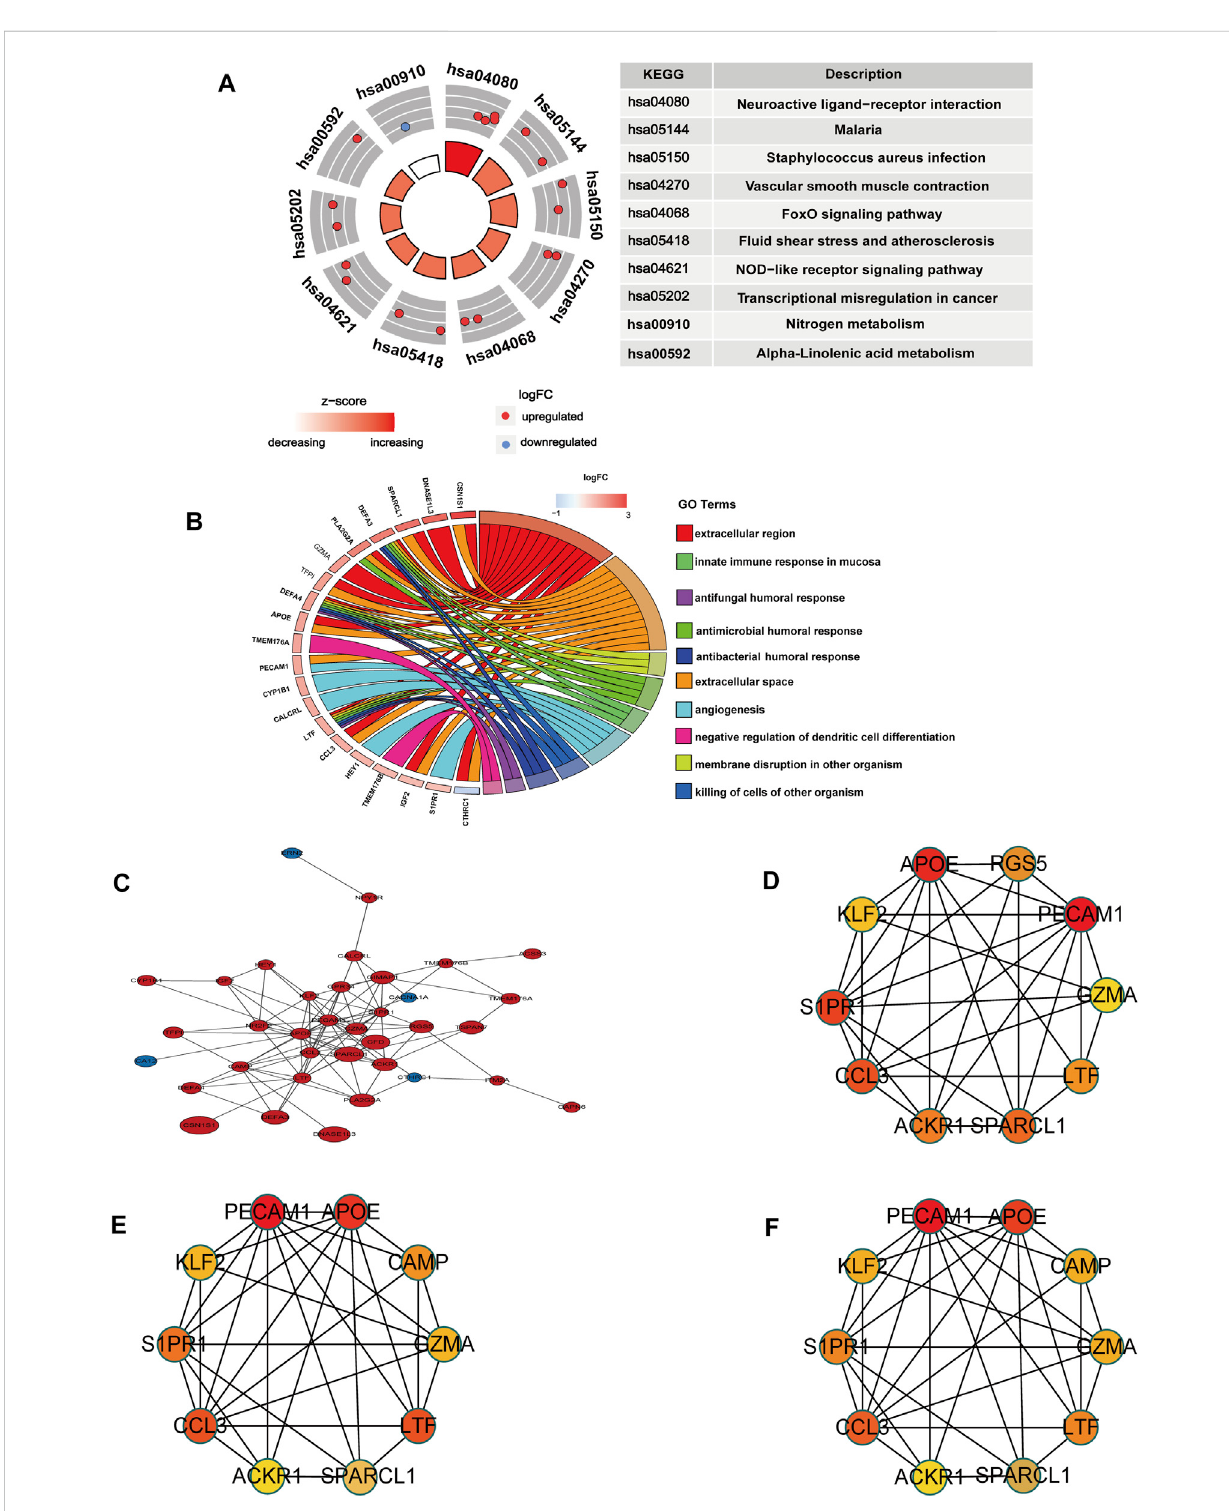
FIGURE 3 Enrichment analysis and PPI network of co-DEGs. (A) The circle diagram shows the enrichment analysis results of co-DEGs and the top ten KEGG pathways. Red dots represent upregulated genes and blue dots represent downregulated genes. (B) Chord plot shows the association of co-DEGs with the top ten GO terms, colors are represented by logFC values. (C) PPI network of co-DEGs, blue represents downregulated genes, red represents upregulatedgenes,andsizerepresentslogFCvalues. (D) GenesetnetworkdiagramofMCCalgorithmincytoHubba,theredderthecolor,thehigher the ranking, and the yellower the color, the lower the ranking (E) The gene set network diagram of the Degree algorithm in cytoHubba, the redder the color,thehighertheranking,andtheyellowerthecolor,thelowertheranking. (F) ThegenesetnetworkdiagramoftheMCNalgorithmincytoHubba,the redder the color in the box, the higher the ranking, and the yellower the color, the lower the